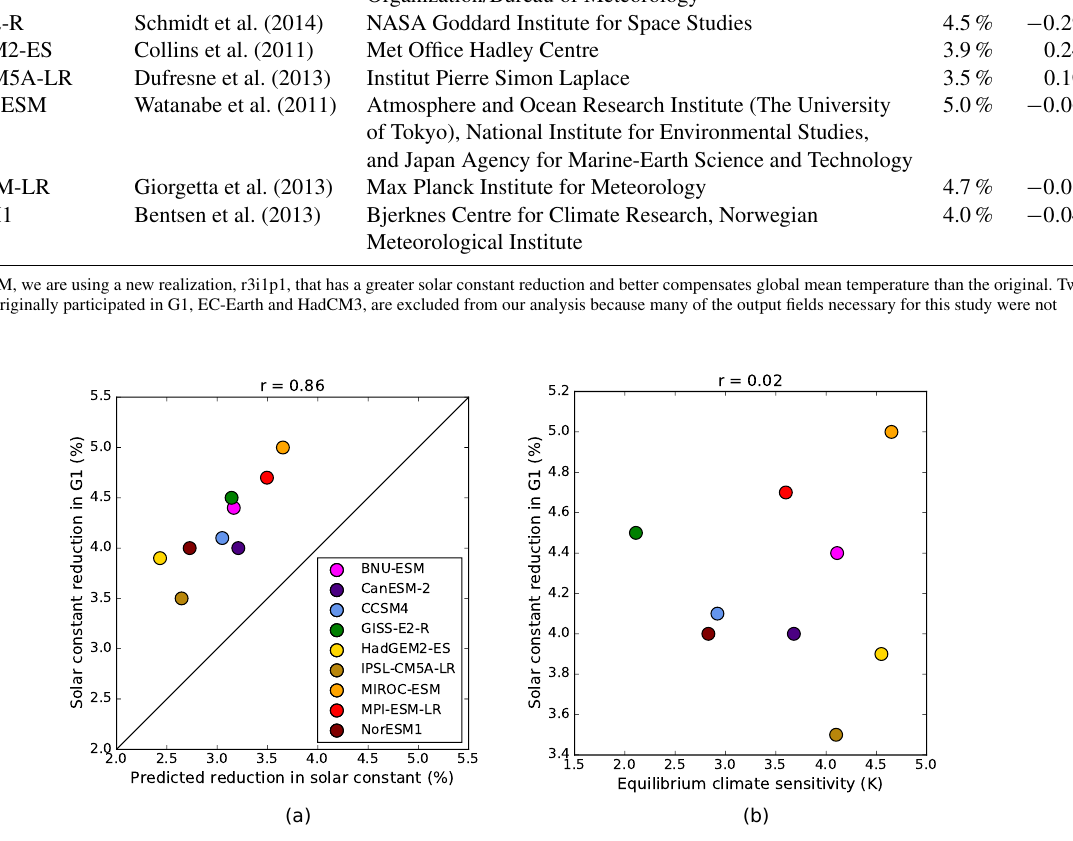
Figure 1. Percent solar constant reduction for models running the G1 experiment versus (a) solar constant reduction predicted by Eq. (2), based on effective radiative forcing values from Sherwood et al. (2014) and pre-industrial planetary albedo values from Kravitz et al. (2013a), and (b) equilibrium climate sensitivity in the models, from Sherwood et al. (2014). CESM-CAM5.1-FV and CSIRO-Mk3L-1-2 are excluded from this figure because these models were not included in Sherwood et al.